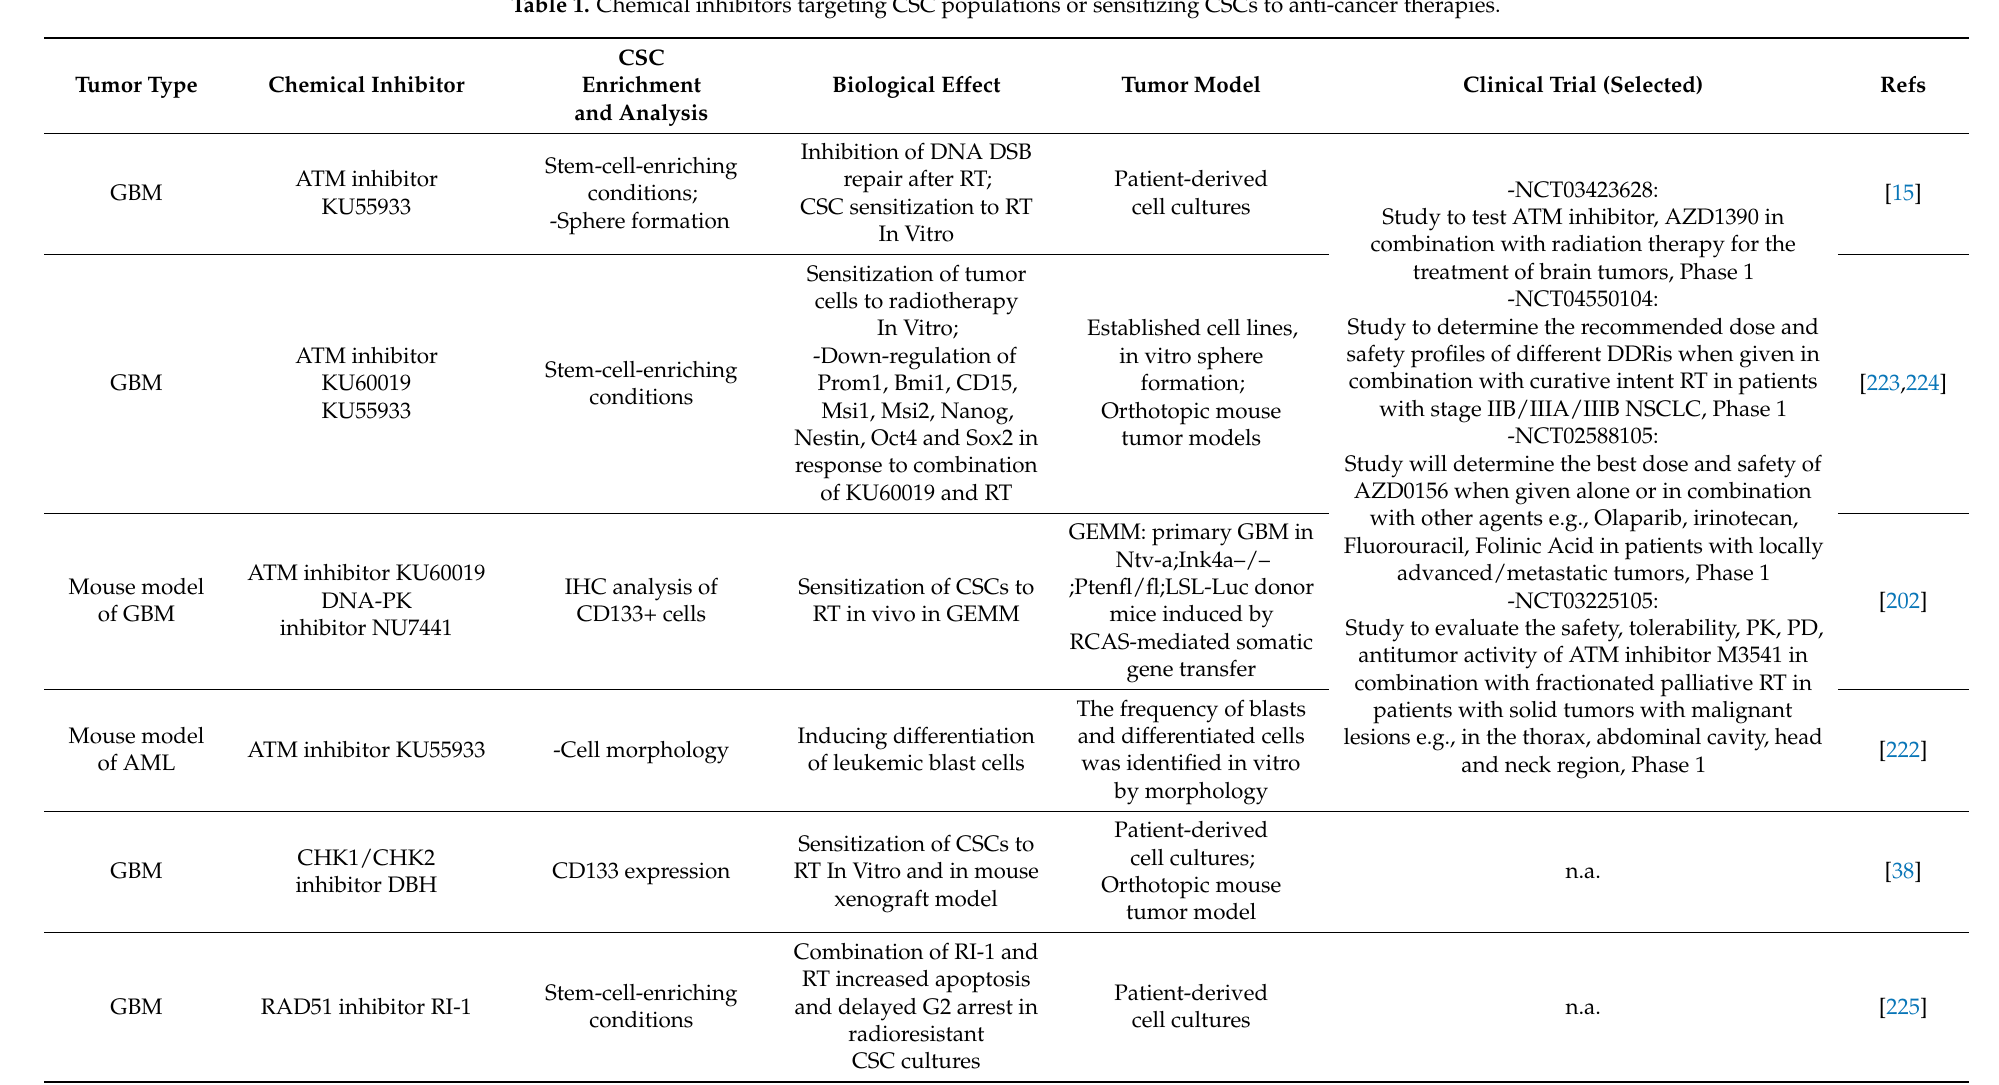
Table 1. Chemical inhibitors targeting CSC populations or sensitizing CSCs to anti-cancer